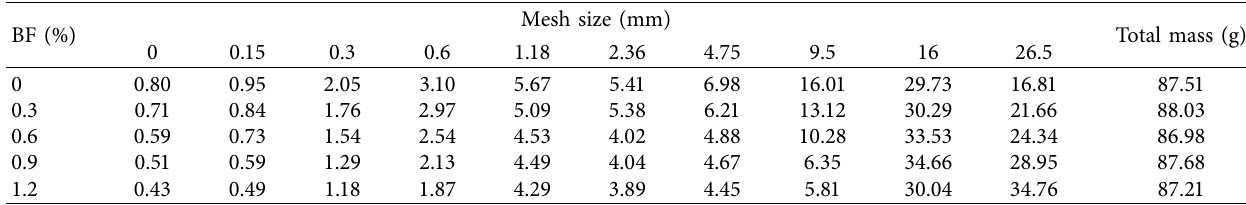
Table 4: Sieving test results of impact fragments of basalt fiber-reinforced cement-fly ash-stabilized soil (0.4MPa impact loading pressure).